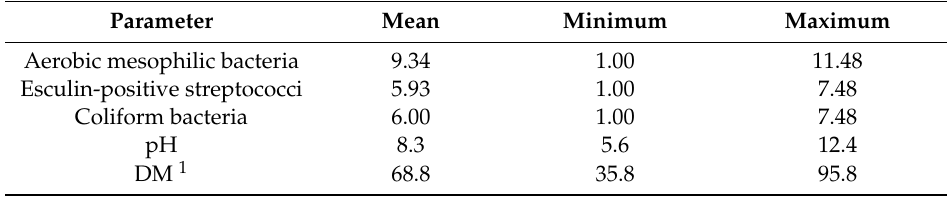
Table 3. Bacterial counts (log 10 cfu / mL), pH and dry matter (%) of 120 bedding samples. Parameter